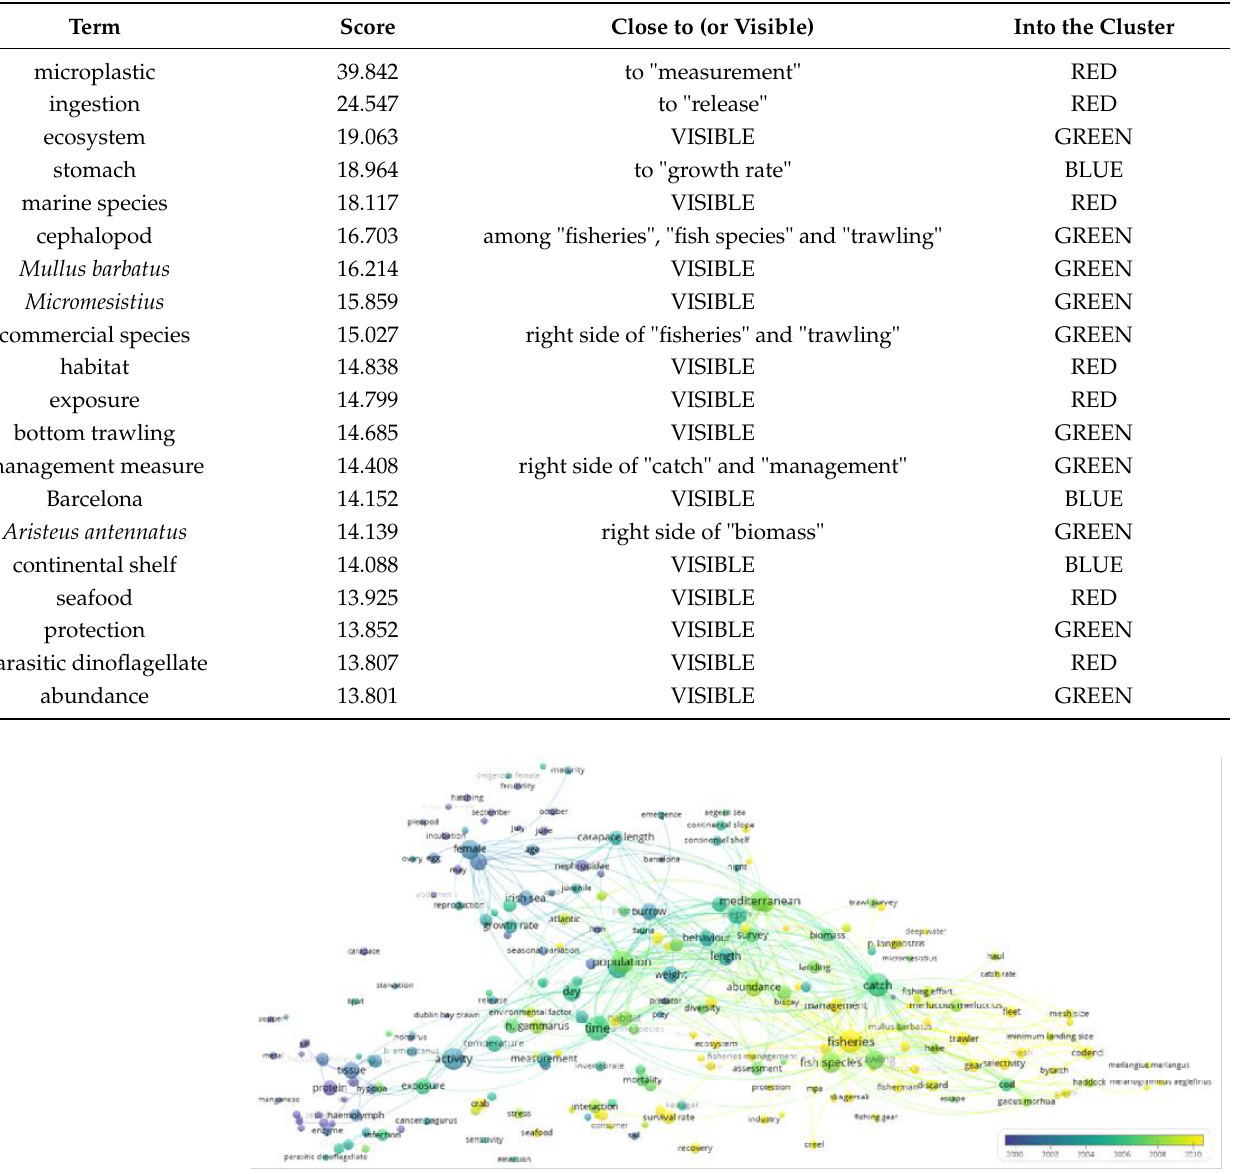
Figure 4. Term year map analysis results, depicting the global temporal trend in the development of research topics.